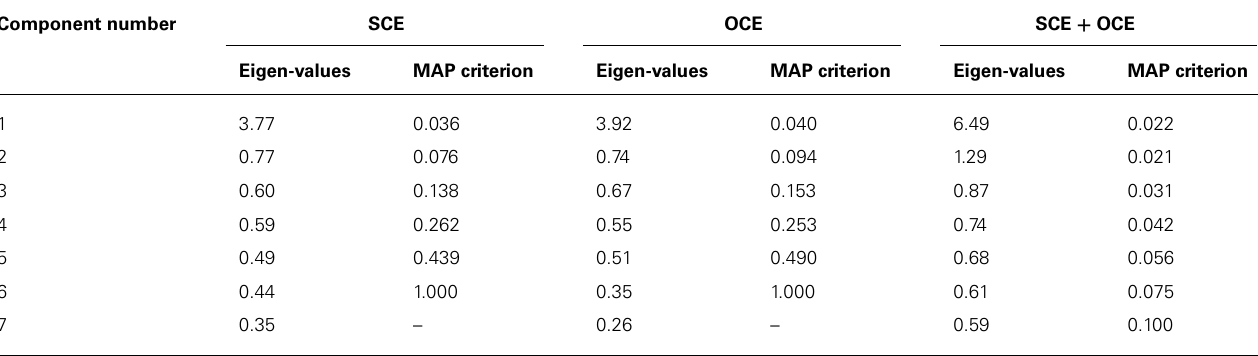
Table 1 |Assessment of number of